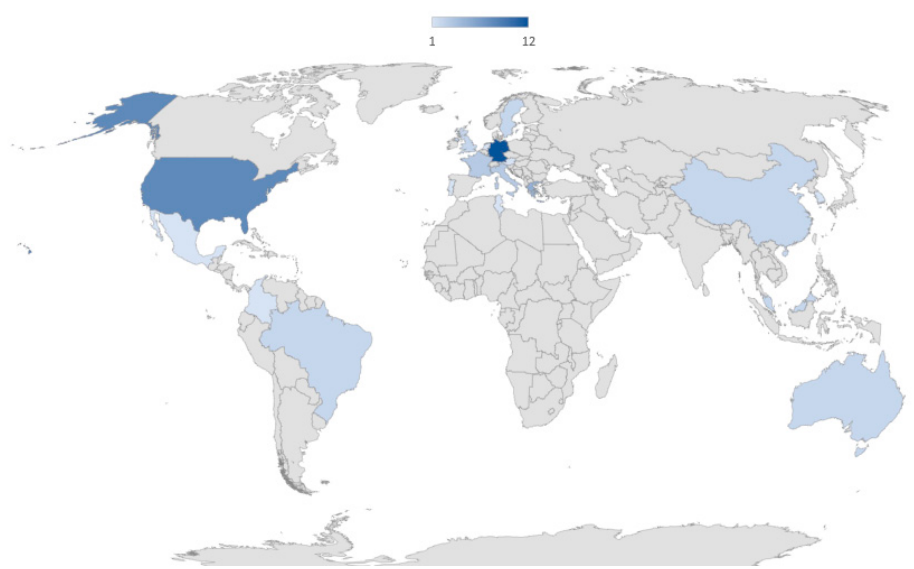
Figure 6. Geographic distribution of the 55 reviewed papers.